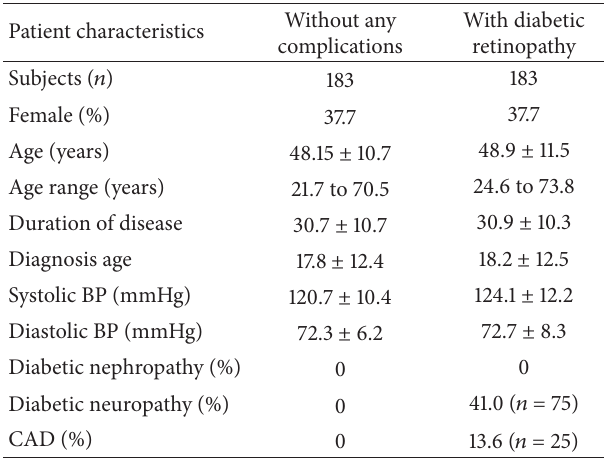
Table 3: Baseline characteristics of T1D subjects without complica- tions and with diabetic retinopathy after